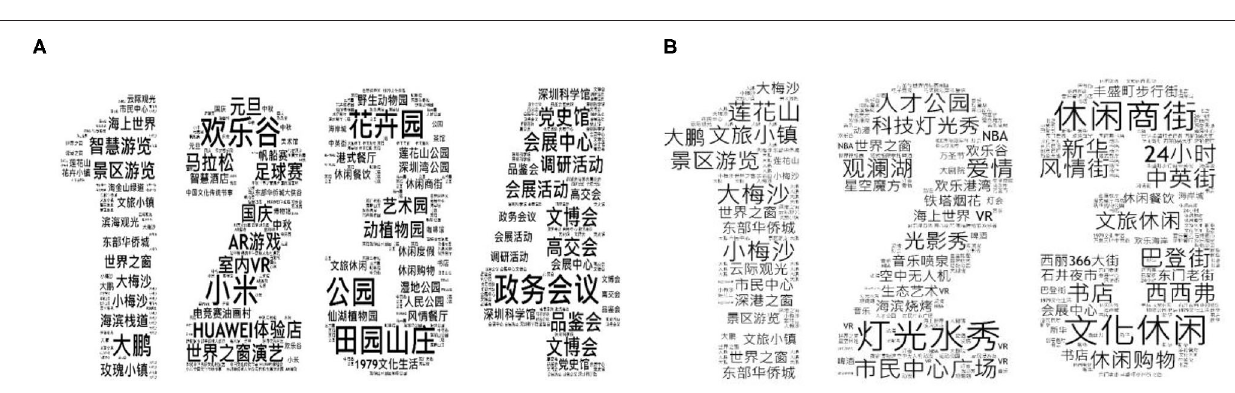
China’s theme business with practical action. Leisure